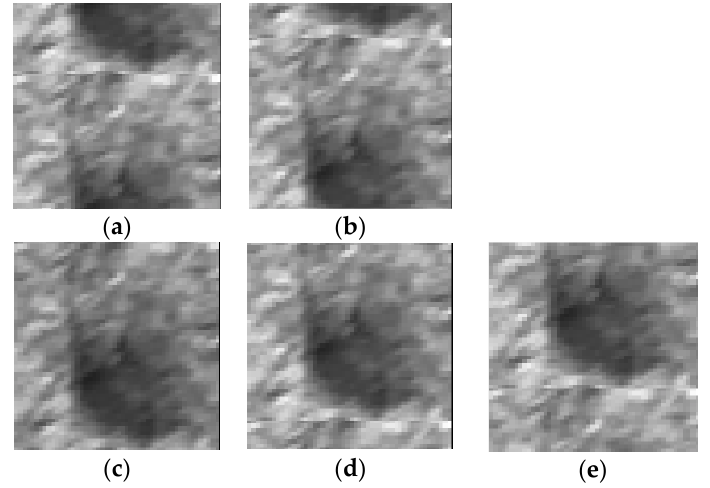
Figure 4. Sample images obtained by circulant matrices: ( a ) image reduced by 40 pixels; ( b ) image reduced by 20 pixels; ( c ) base image; ( d ) image increased by 20 pixels; ( e ) image increased by 40 pixels.